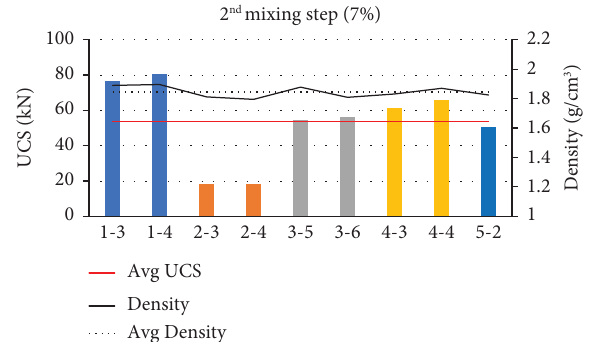
Figure 7: Phase 1: UCS results of samples taken from second mixing step (90 days of